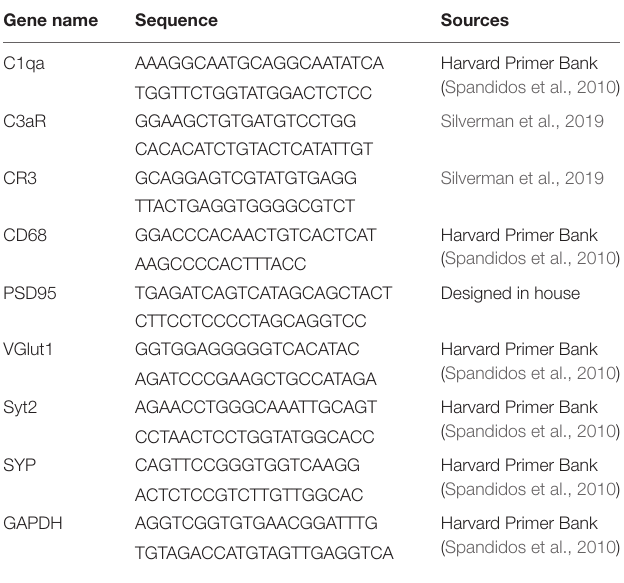
TABLE 2 | qRT-PCR primers used in mRNA